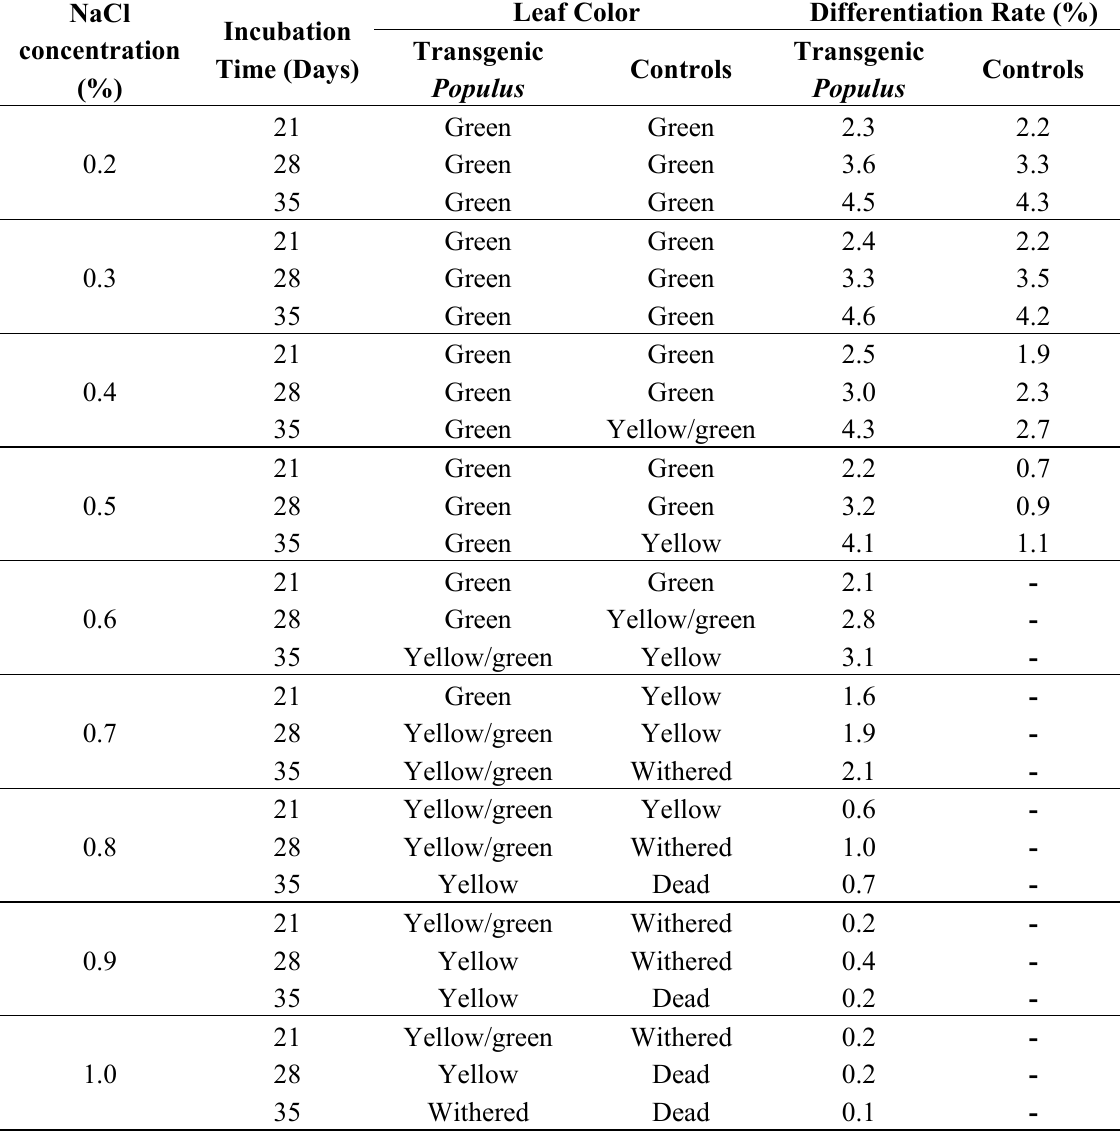
Table 1. Proliferation at various NaCl